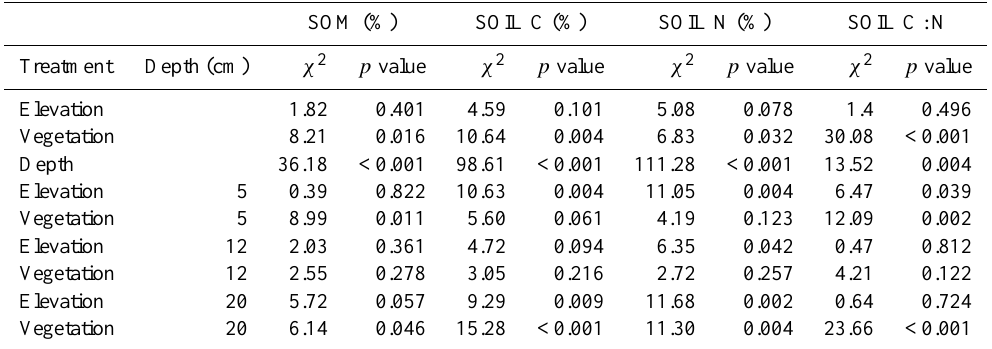
Table C1. Kruskal–Wallis rank sum test results for the effects of elevation, vegetation, and soil depth on soil organic matter (SOM %), soil C (%), soil N (%), and soil C:N